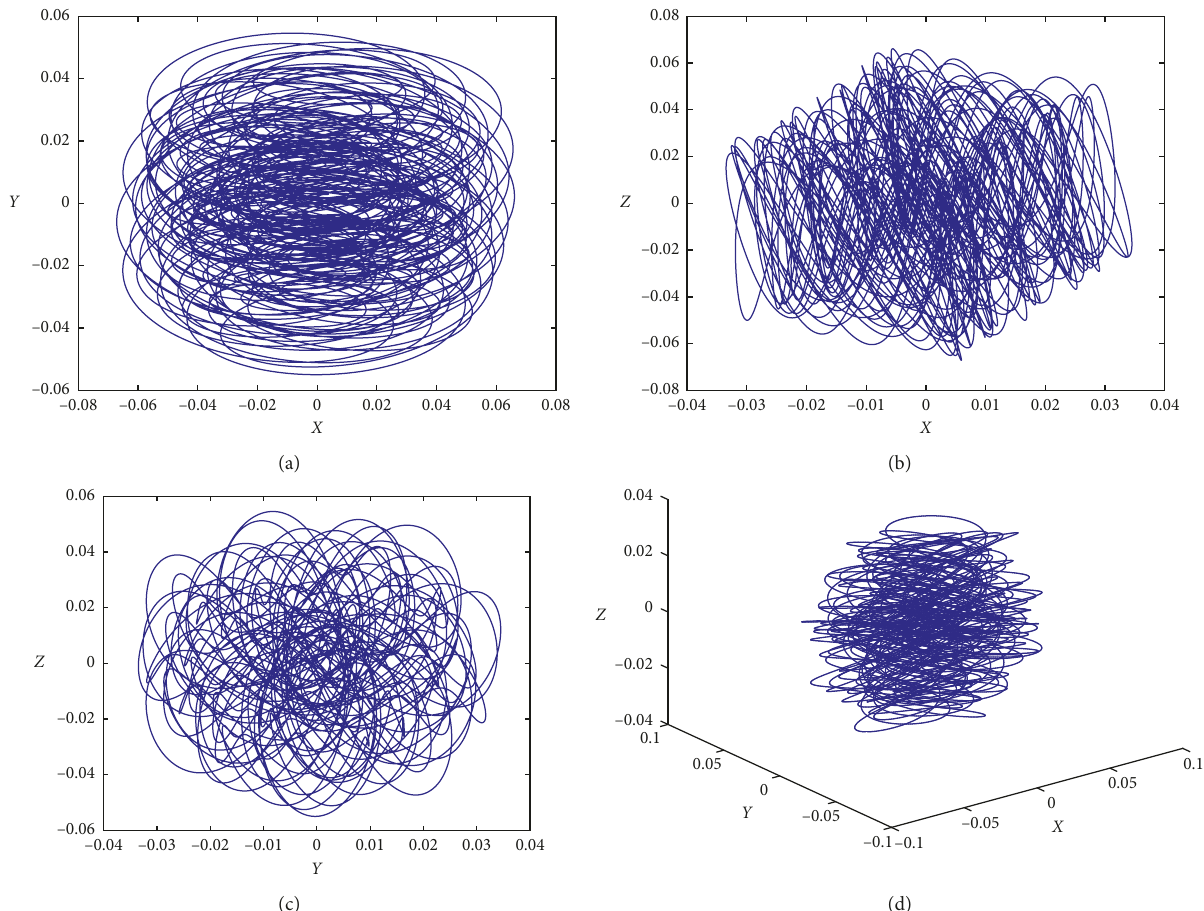
Figure 3: Phase portraits of system (6). Phase portraits of (a) system (6) x vs. y , (b) system (6) x vs. z , (c) system (6) y vs. z , and (d) system (6) x vs. z vs. z